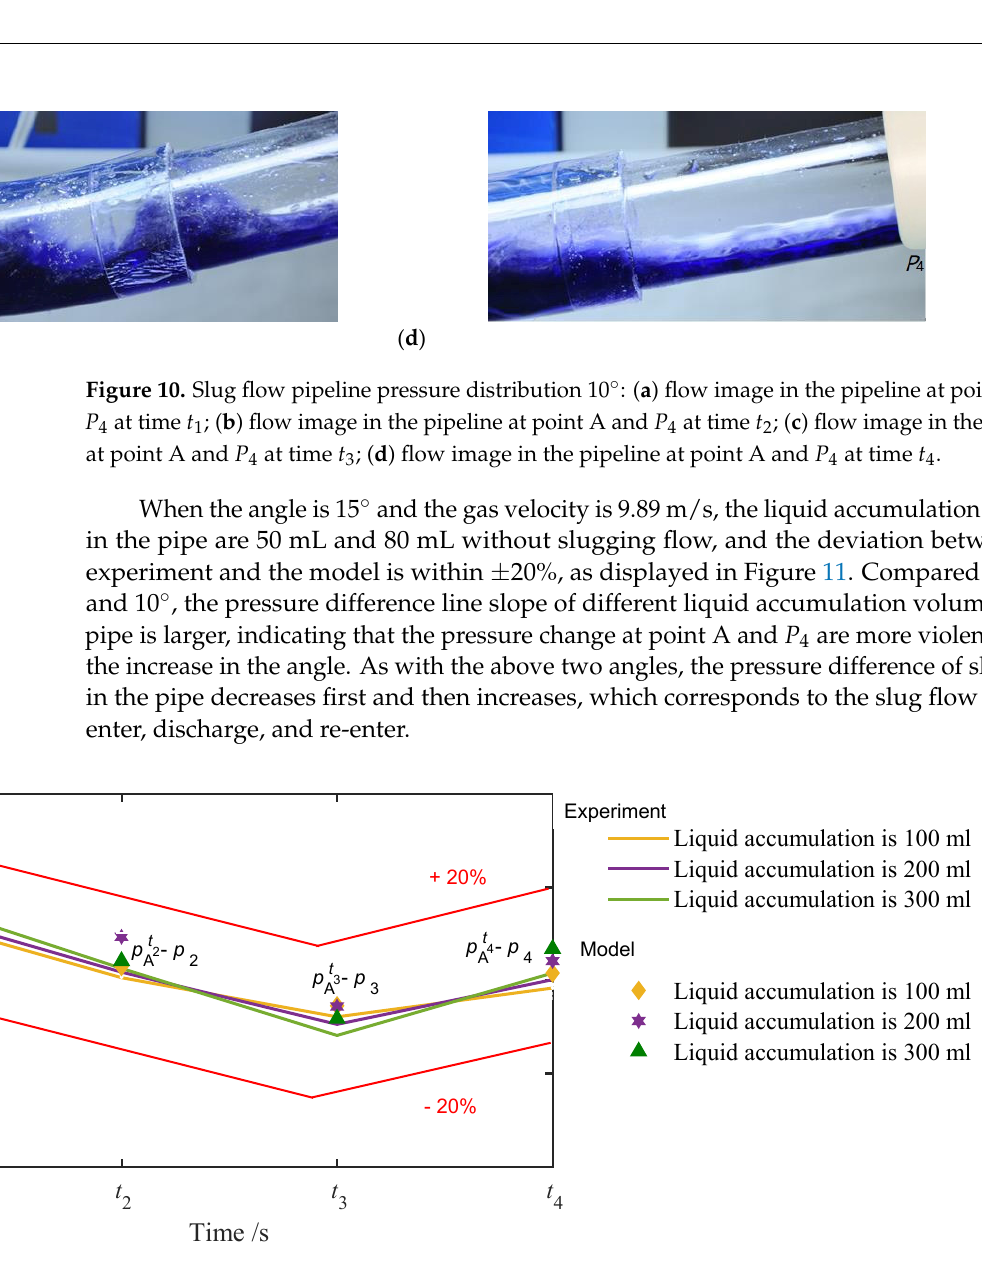
an inclination angle of 15° and a gas velocity of 9.89 m/s. From t 1 to t 4 , the liquid Figure 11. Verification of slug flow pressure model with an inclination of 15°. Figure 11. Verification of slug flow pressure model with an inclination of 15 ◦ accumulates twice at point A and flows out once in the inclined pipe. The movement form is consistent with the pressure model established in Section 3.